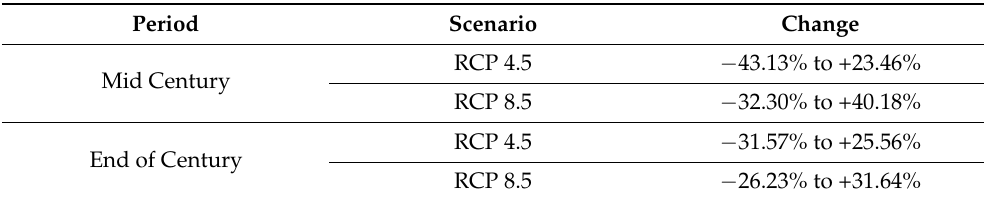
Figure 9. The projected precipitation change in percentage from MC to EC, concerning historical precipitation for the multimodel ensemble of RCM (RCP 8.5). Table 3. The Range of percentage change in the projected precipitation concerning the historical